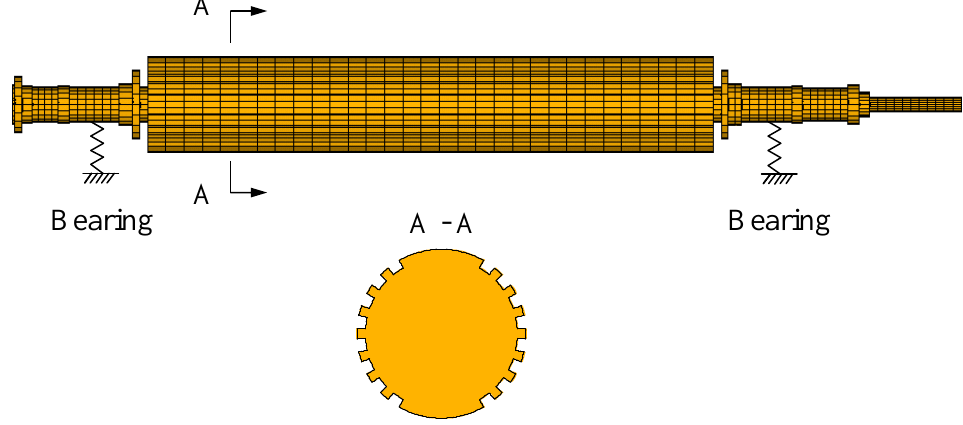
Figure 1. The schematic diagram of a generator rotor system.